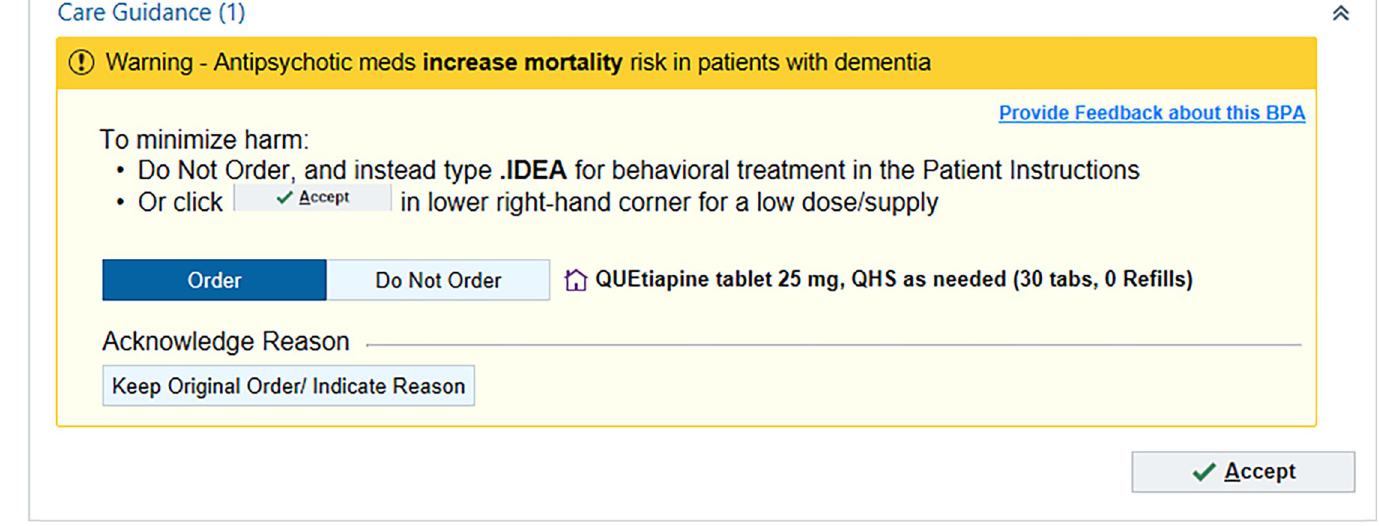
Fig 3. CONSORT flow